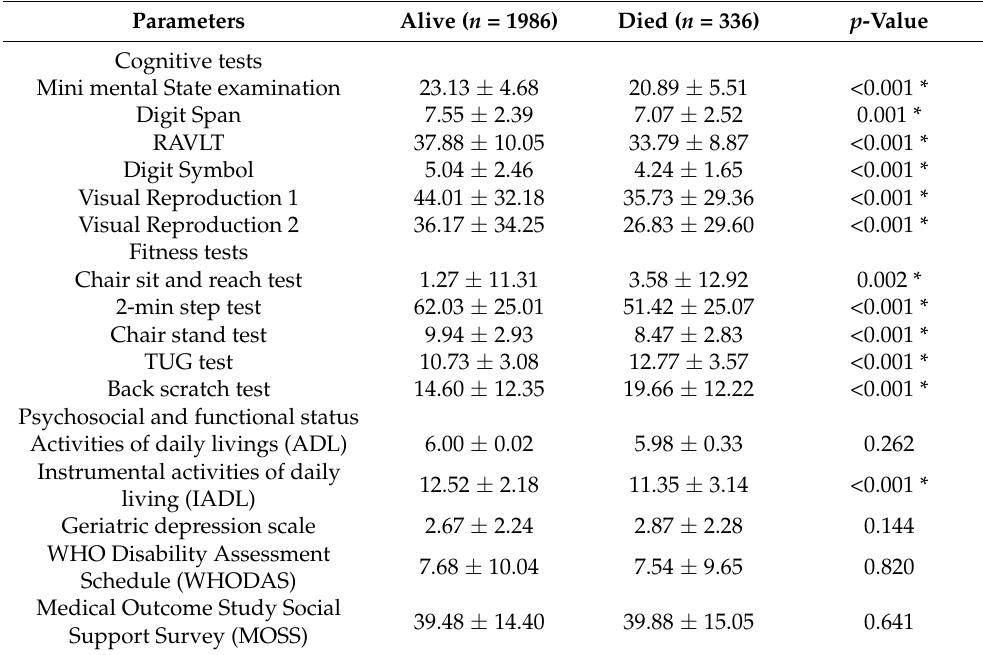
Table 4. The baseline cognitive function, physical function and psychosocial status of respondents who were alive or died [presented as mean ± standard deviation